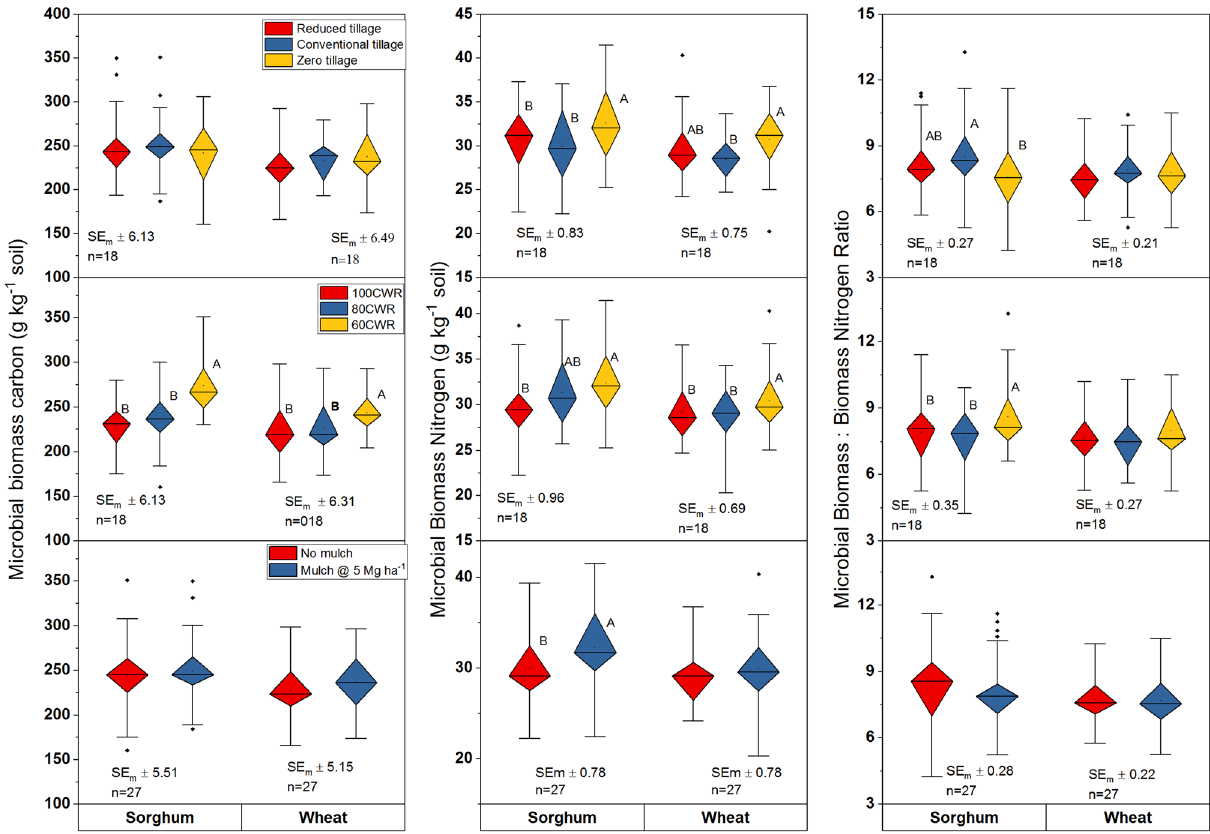
Figure 1. Influence of tillage, irrigation and mulch on dehydrogenase, alkaline phosphatase and urease activities; different uppercase letters (A, B) denote significant differences (** P < 0.01, *** P < 0.001, Tukey’s HSD test). Data are means over 2 years. Irrigation applied only in wheat, sorghum was grown as rainfed; CWR: per cent water requirement for wheat; SE m ± : standard